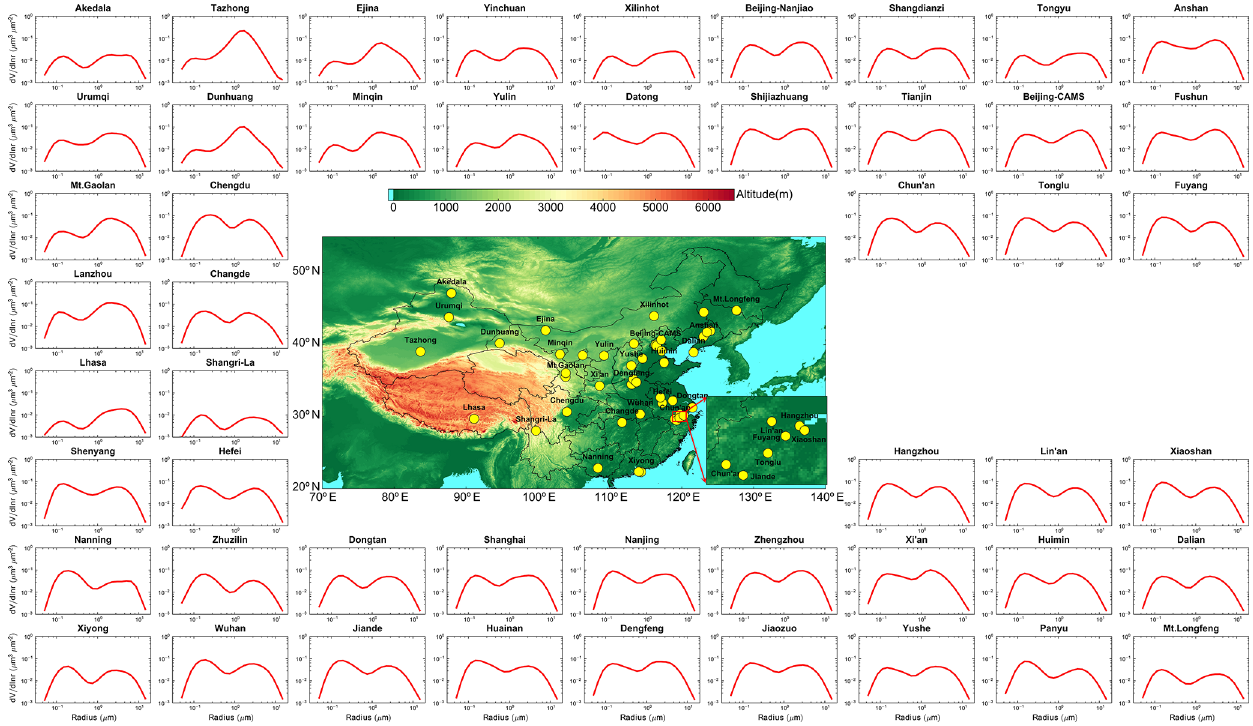
Figure 1. Annual spatial distribution of aerosol volume–size distributions at the CARSNET